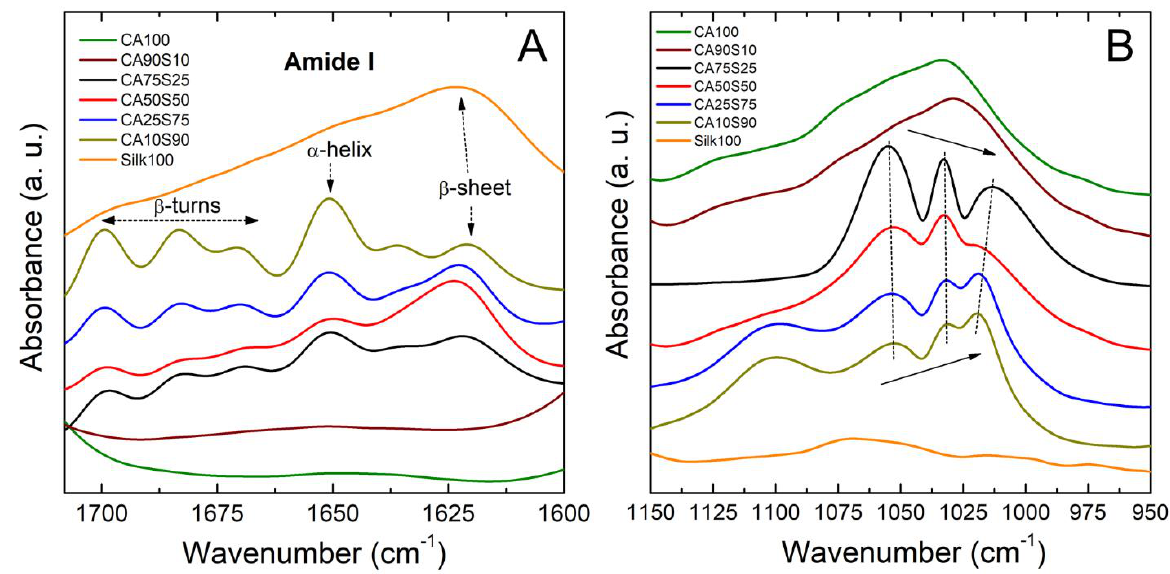
Figure 3. FTIR spectra for silk-cellulose acetate films made using a methanol bath. ( A ) The region containing the amide I (1700–1600 cm −1 ) peaks of silk proteins. ( B ) The region depicted is related to the structure of cellulose in the 1150 cm −1 to 950 cm −1 range.